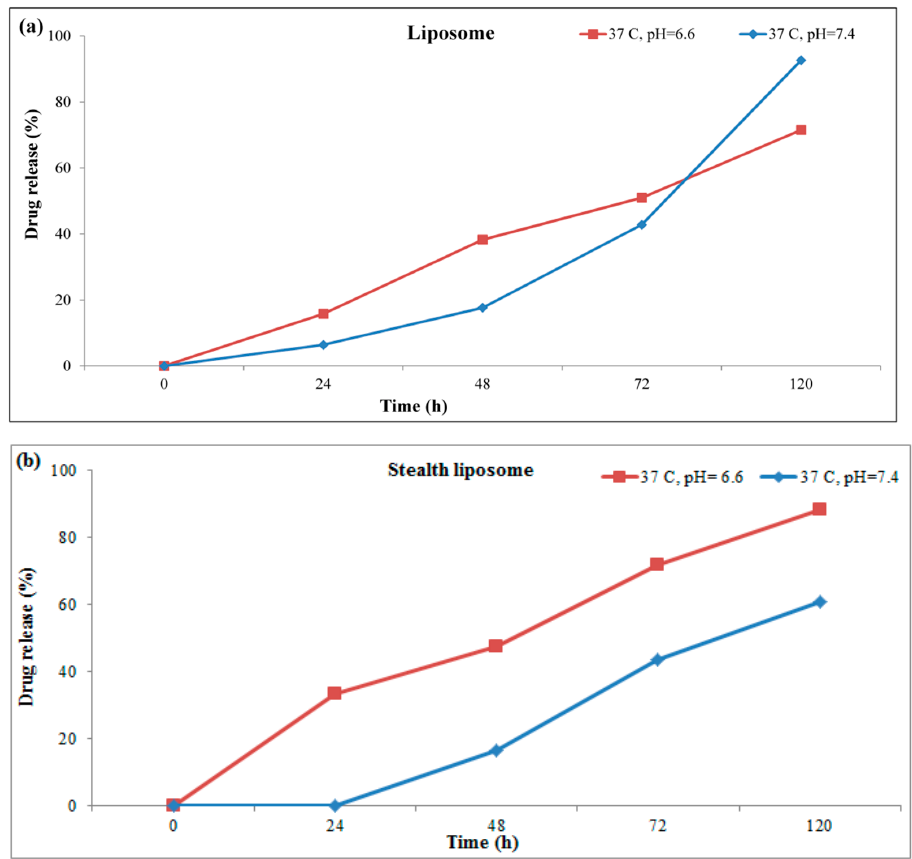
Figure 4. pH ‐ responsive drug released pattern of ( a ) liposome and ( b ) stealth liposome at 37 °C.